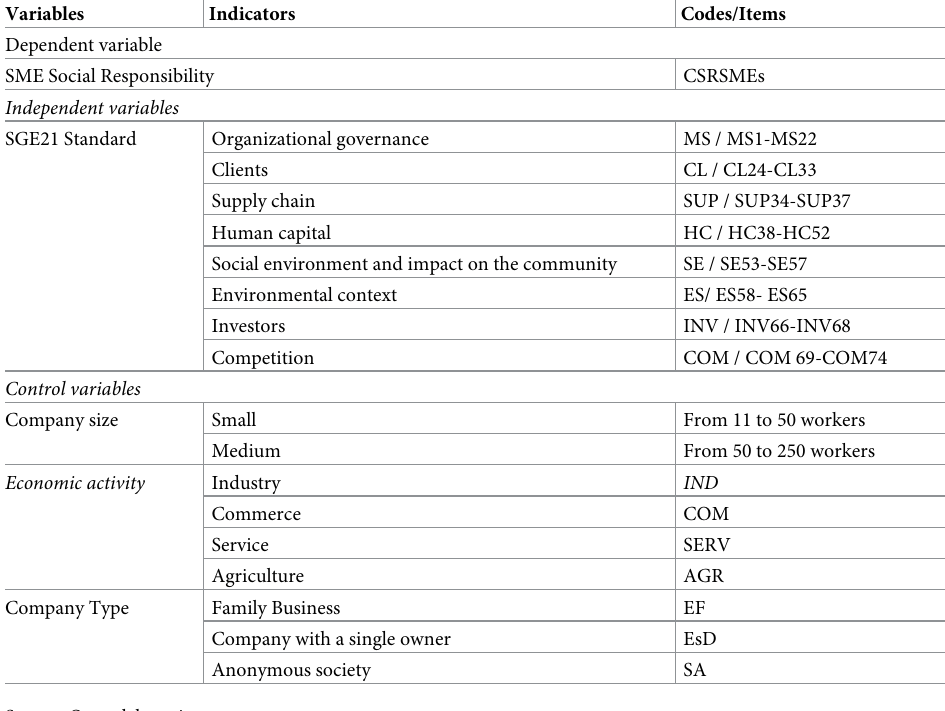
Table 2. Operationalization of CSRSMEs variables and